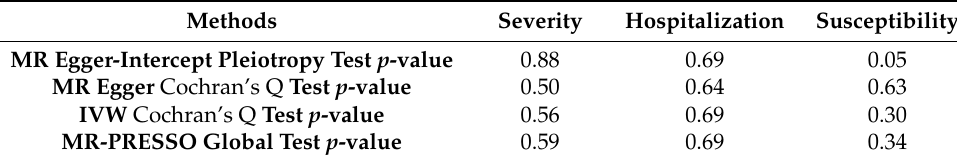
Table 3. Sensitivity analysis: heterogeneity, pleiotropy and